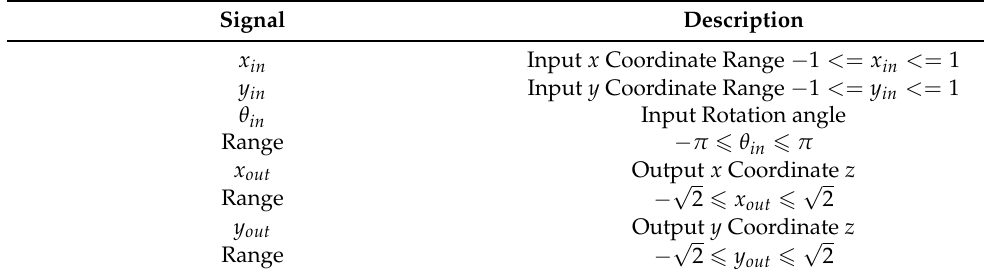
Table 5. Inputs/Outputs-Cordic (Project File: Part 2). Signal